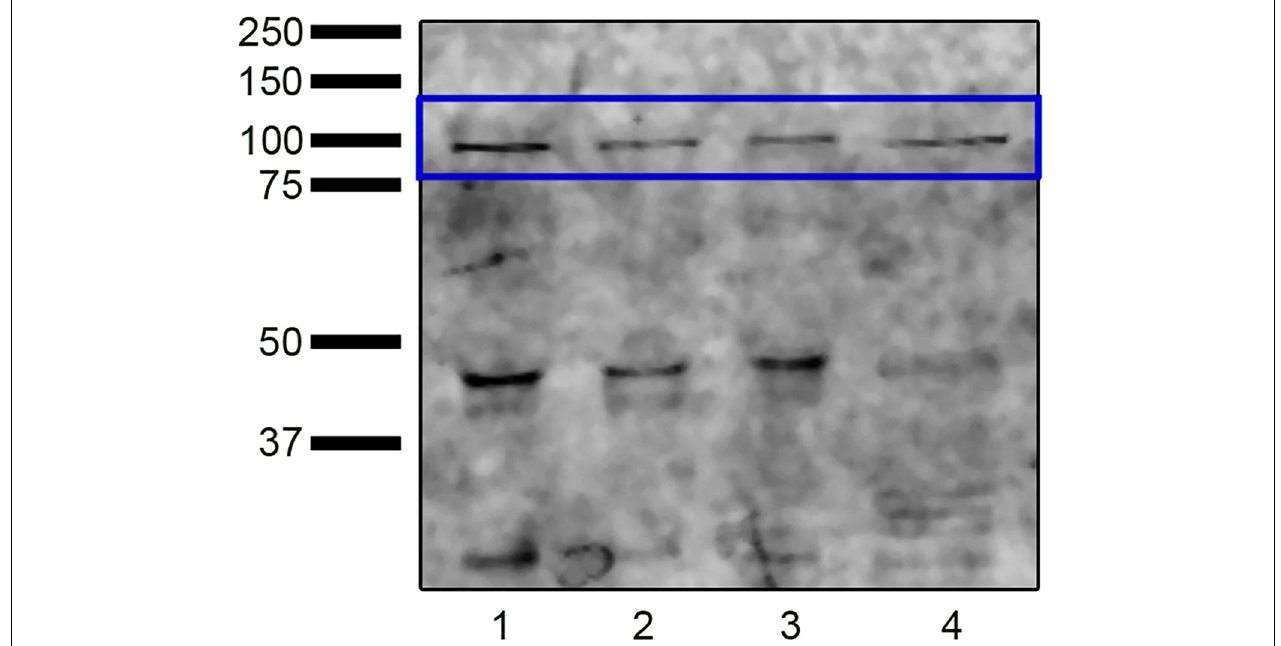
FIGURE 1 | Western blot analysis revealing the presence of NADPH oxidase 5 in ram sperm protein extracts from swim-up selected samples (lane 1) and samples incubated in capacitating conditions without (TALP, lane 2) or with cAMP elevating agents (Cap-C, lane 3). Positive control (lane 4): HeLa cell lysate.